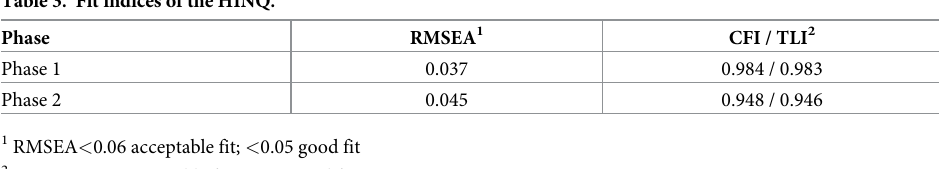
Table 3. Fit indices of the HINQ.